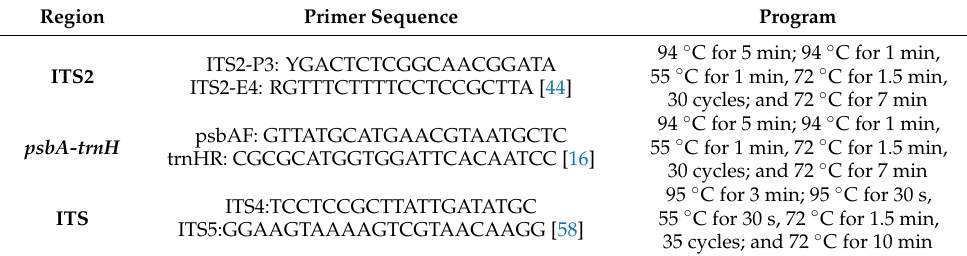
Table 4. The PCR primers and conditions used to amplify each barcode